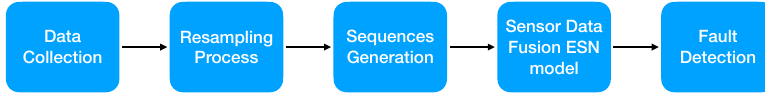
Figure 3. Block diagram showing the steps performed in our